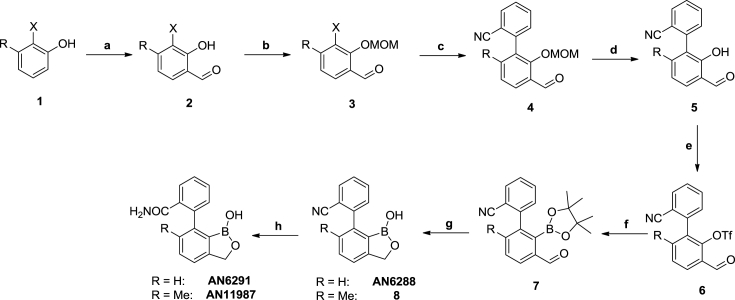
Synthetic pathway of 7-phenyl benzoxaborole compounds. R = H, X = Br; R = Me, X = I; a) (CH2O)n, MgCl2, TEA, MeCN, reflux, overnight, 90%; b) MOMCl, DIEA, DCM, 0 °C, 1 h, 90%; c) 2-cyanophenylboronic acid, Pd(PPh3)2Cl2, Na2CO3, 1,4-dioxane, H2O, 80 °C, 12 h, 46–56%; d) 2 N HCl (aq), THF, 50 °C, 4 h, 64–93%; e) Tf2O, pyridine, DMAP, DCM, rt, 2 h, 45–70%; f) (PinB)2, KOAc, Pd(PPh3)2Cl2, 1,4-dioxane, N2, 80 °C, 6 h, 67–87%; g) NaBH4, MeOH, THF, rt, 0.5 h; 6 N HCl (aq), rt, 0.5 h, 56–66%; h) NaOH, H2O, 80 °C, 8 h, 32–64%.